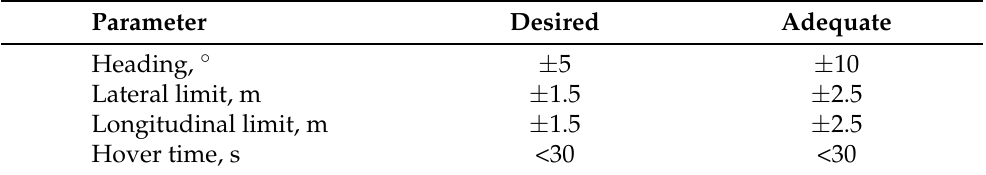
Table 7. Performance limits of the pilot task for hovering